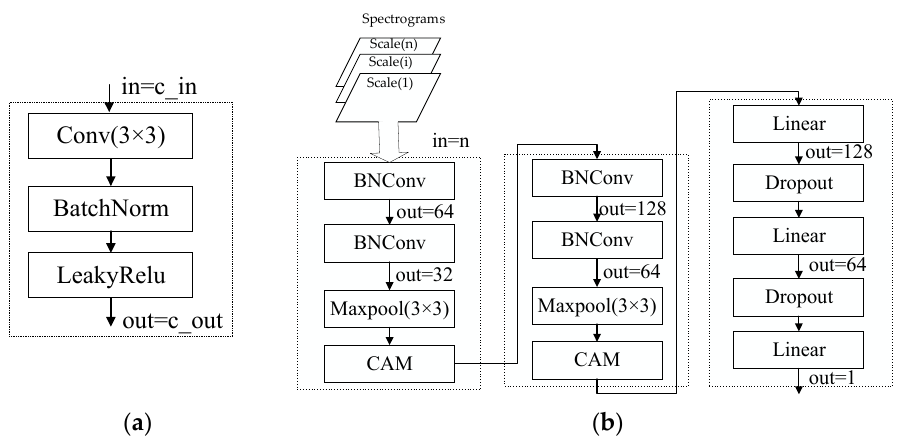
Figure 9. The proposed CNN architecture ( b ), in which BNConv is the block ( a ) that consists of a convolution layer, a Batch Normalization layer, and a Leaky ReLU.